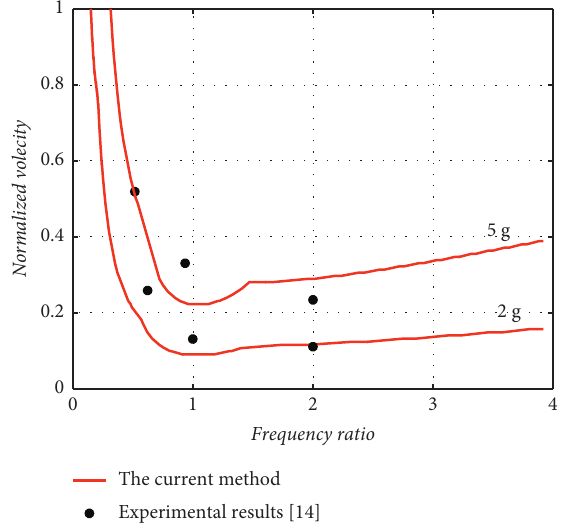
Figure 6: DDBCs of a packaging system with tangent stiffness obtained from a simulation and experiment at 2 g and 5 g .